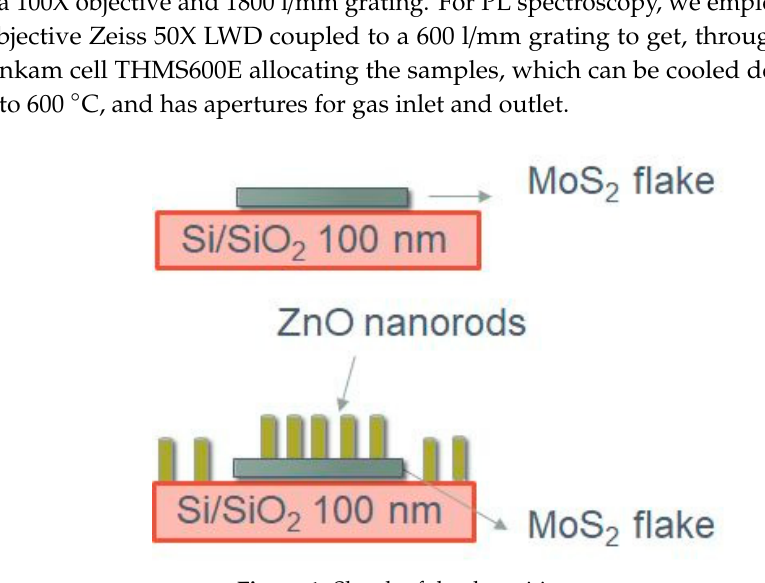
Figure 1. Sketch of the deposition steps.